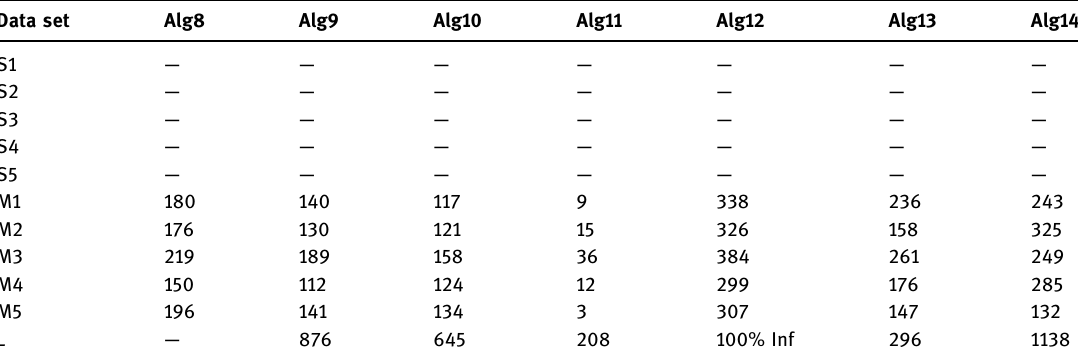
Table 3: Comparing our results with other approaches in the